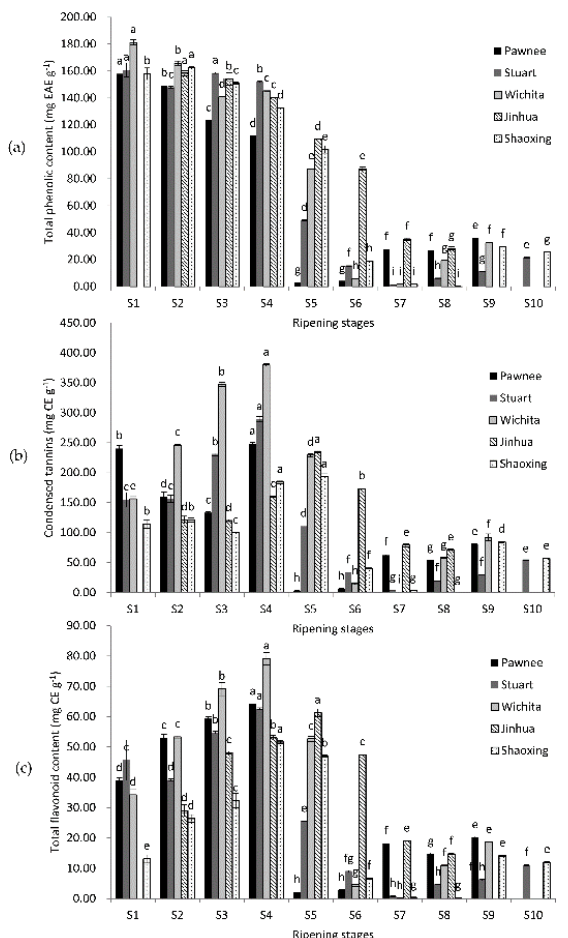
Figure 1. Changes in total phenolic content ( a ), condensed tannins ( b ), and total flavonoid content ( c ) during the ripening of pecan kernels. Each value is a mean ± standard deviation of triplicate analysis results of different samples. Means with different letters in each line were significantly different according to the multiple-range Tukey’s test at p < 0.05.